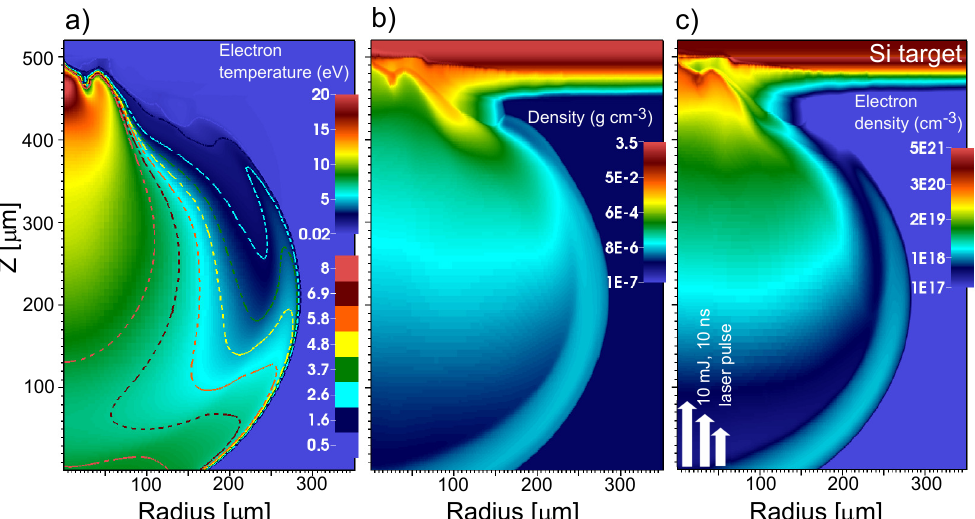
Figure 5. ( a ) The spatial distributions of the plasma electron temperature (in units of eV); ( b ) the plasma density (in units of g cm − 3 ); and ( c ) the plasma electron density (in units of cm − 3 ) for a 10 ns LPP near the peak irradiance of ≈ 10 10 Wcm − 2 over the Radius-Z space calculated using a 2D Eulerian FLASH code. The laser beam propagates along the Z direction as shown in ( c ). Here, a dashed-lines contour in Figure 5a shows the locations with the electron temperatures in the range of ≈ 0.5–8